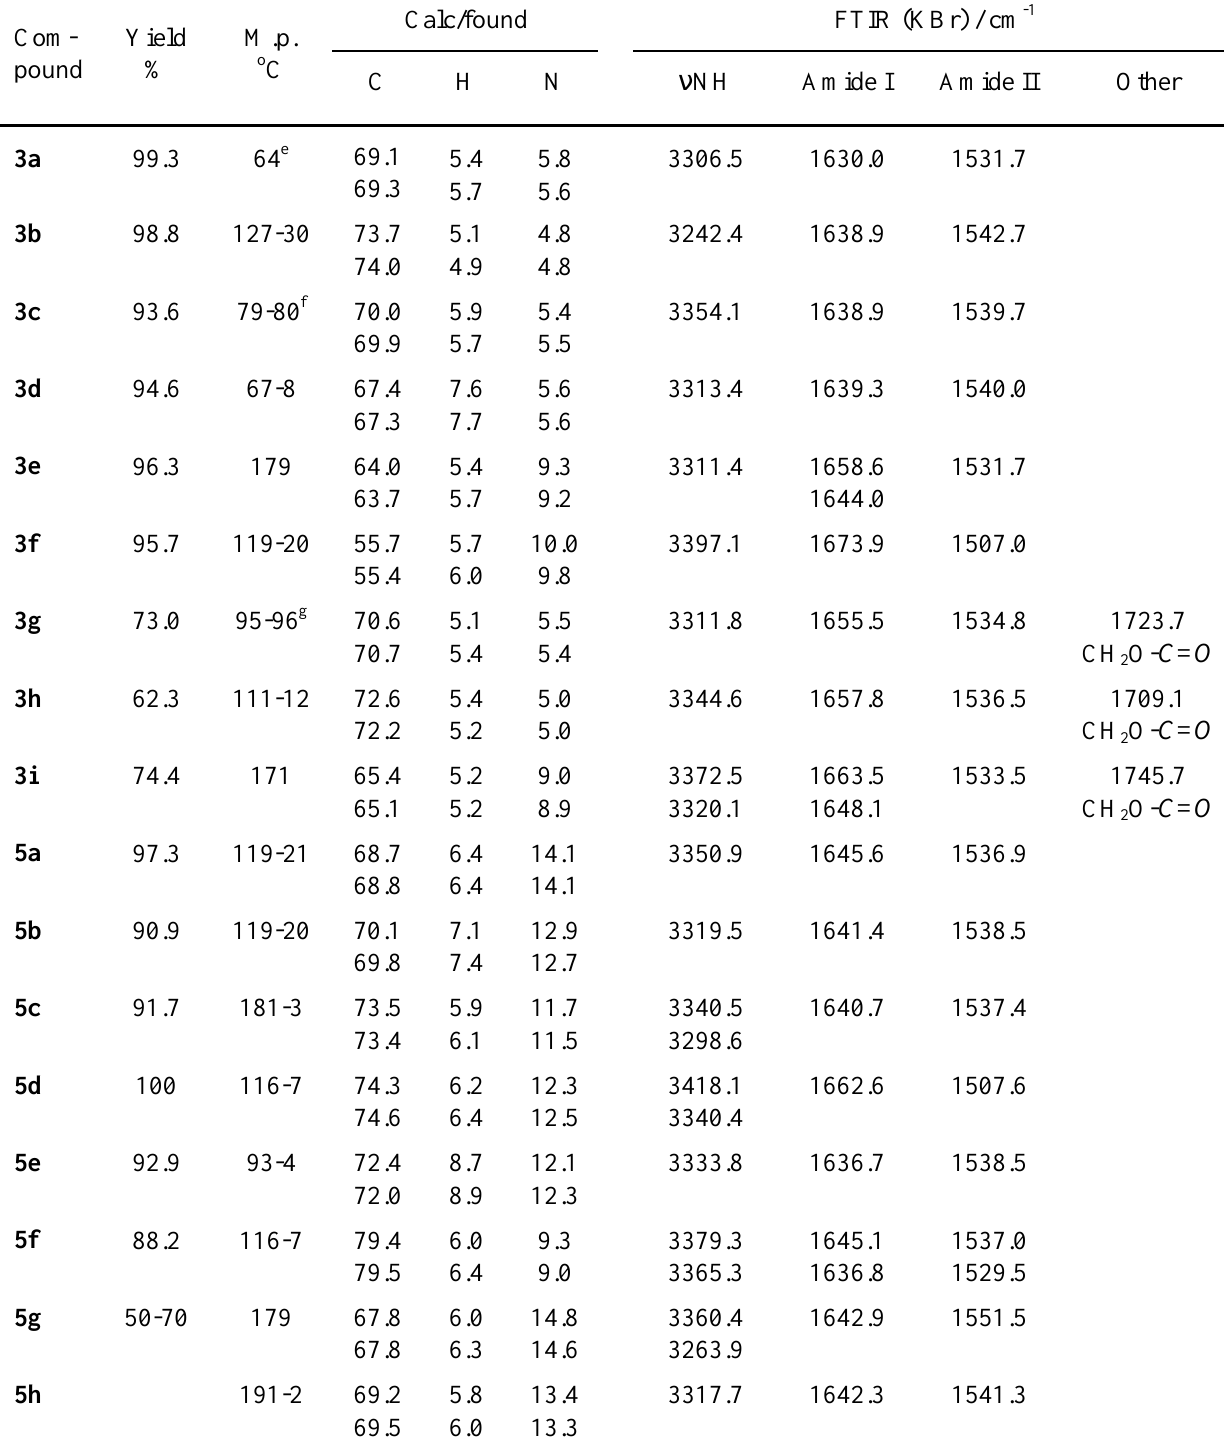
Table 2. Physicochemical data of compounds 3a - i and 5a - h . Calc/found FTIR (KBr) / cm -1